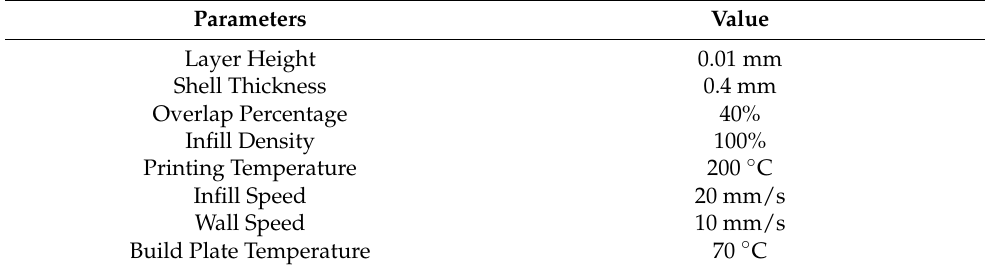
Table 1. The main parameters of the actuator FDM process.